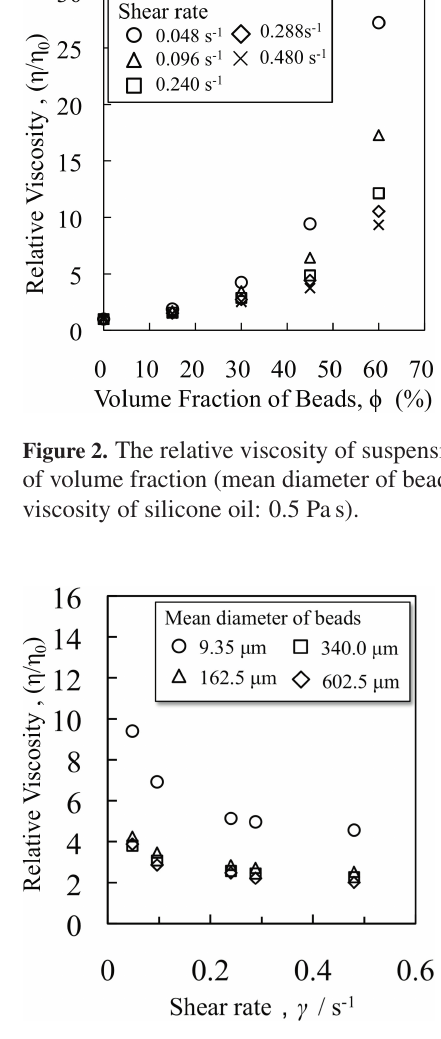
Figure 3. The relative viscosity of suspension as a function of shear rate (volume fraction of beads: 45%, viscosity of silicone oil: 0.5 Pa